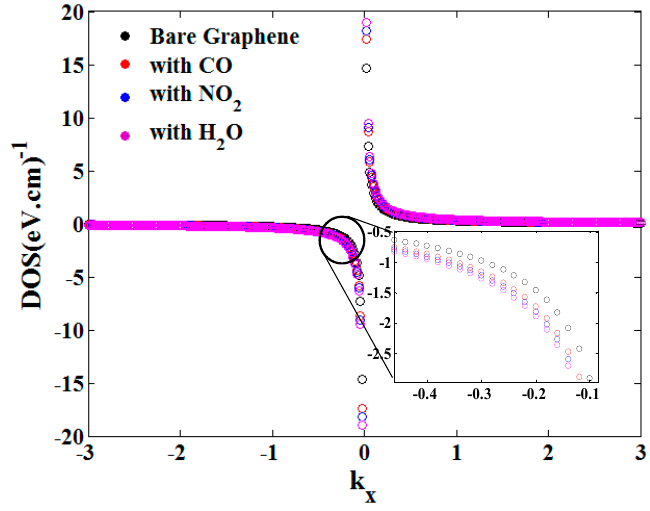
Figure 5. Gas adsorption effect on the graphene density of states.